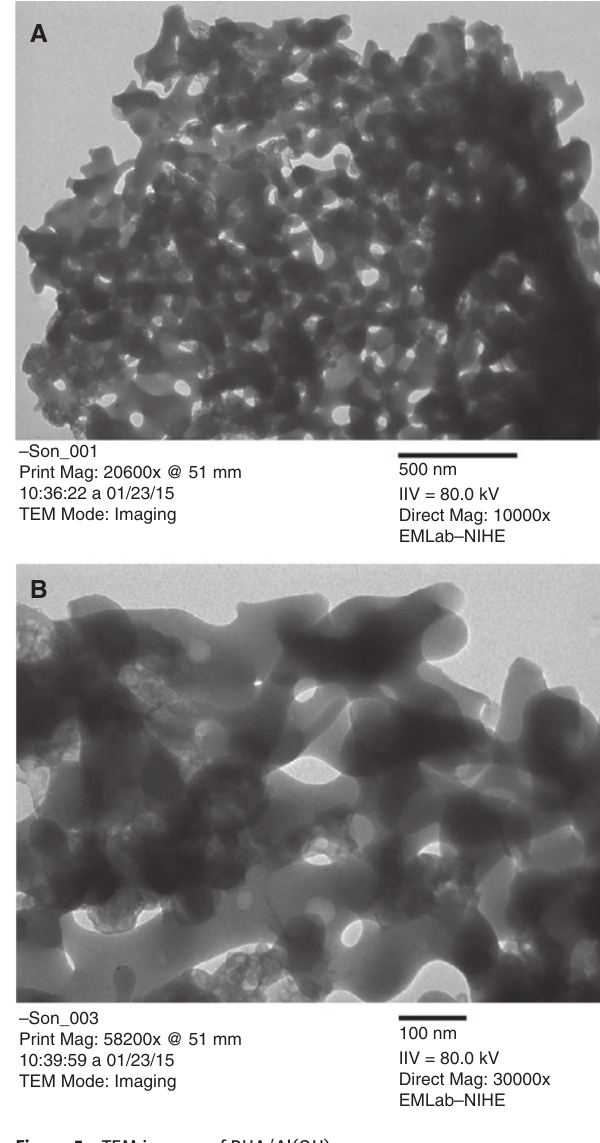
Figure 5: TEM images of RHA/Al(OH)